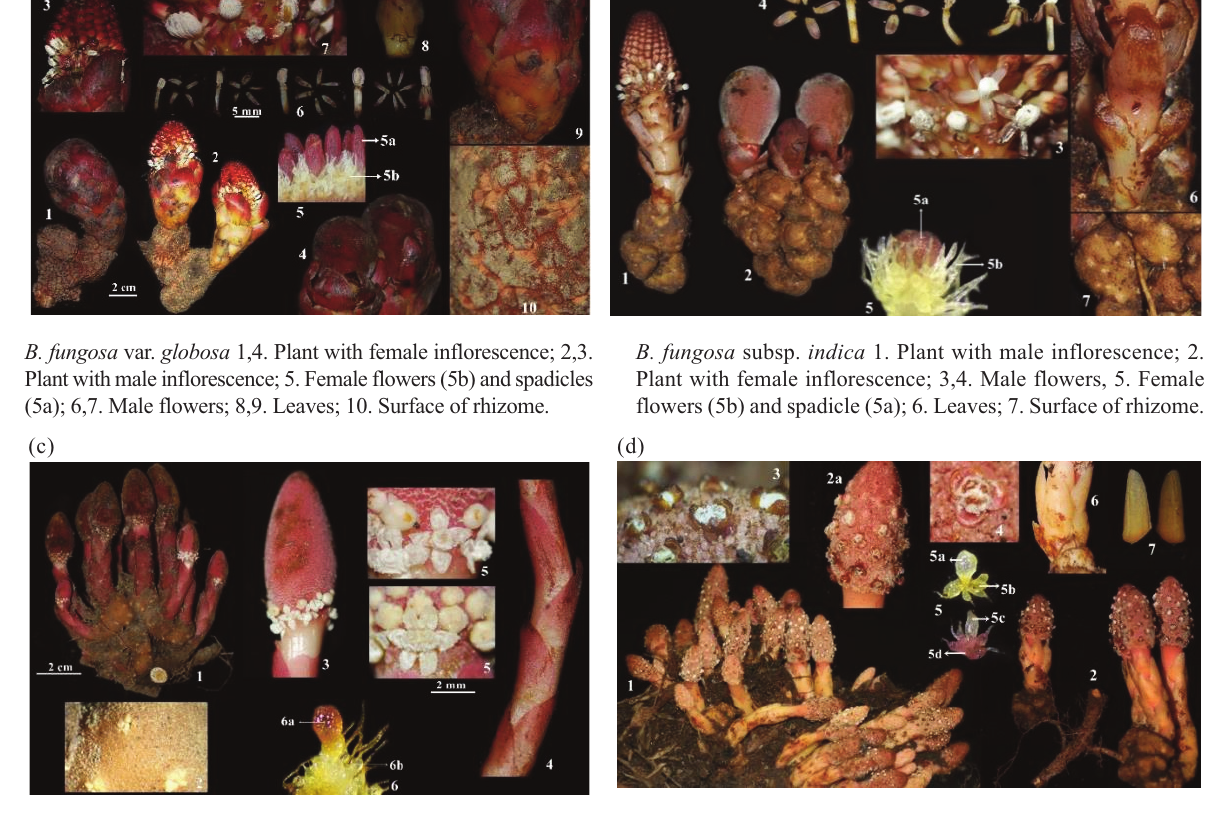
Fig. 1. Morphological characteristics of some Balanophora